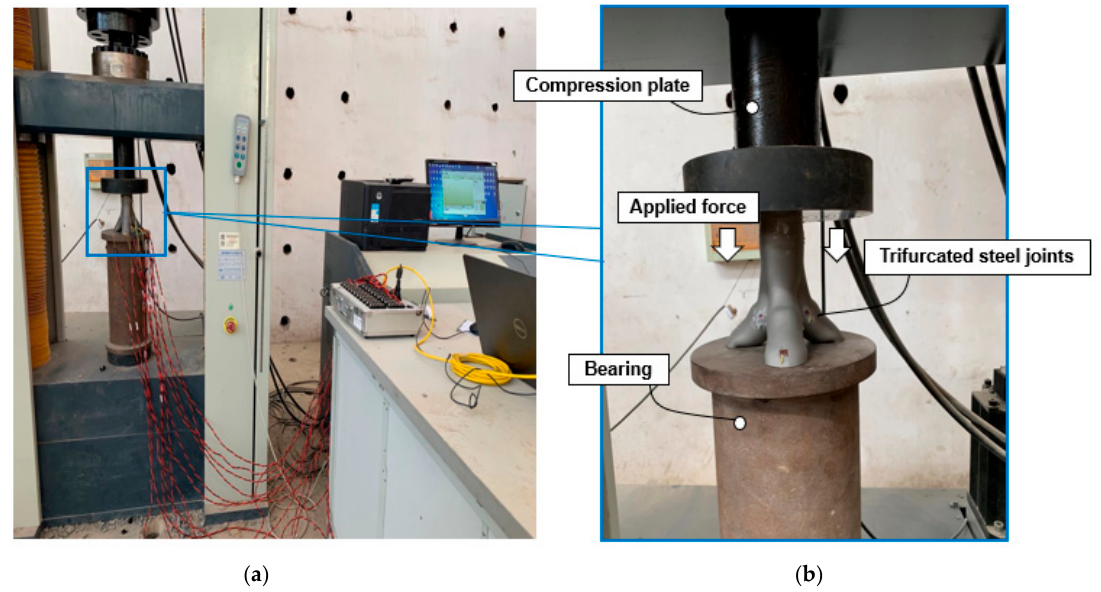
Figure 13. Testing of additive manufactured trifurcated joint: ( a ) Schematic diagram of the experimental setup; ( b ) an enlarged view of the local position.